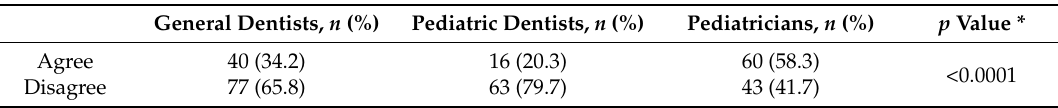
* Statistical significance determined through chi-square test.